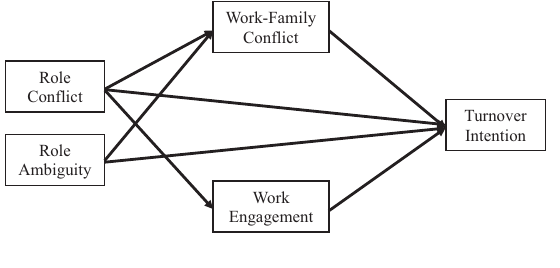
Figure 1. Research